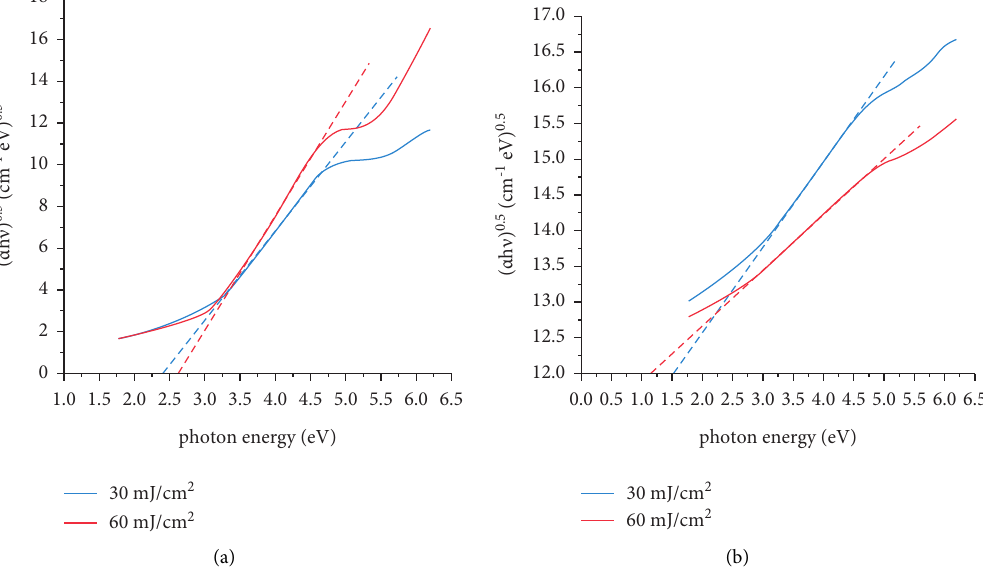
Figure 8: The ( α h ] ) 0.5 versus photon energy plot of the NPs prepared by LASER ablation in liquid with a LASER fluence of 30 and 60mJ/ cm 2 : (a) without the magnetic field and (b) with the presence of the magnetic